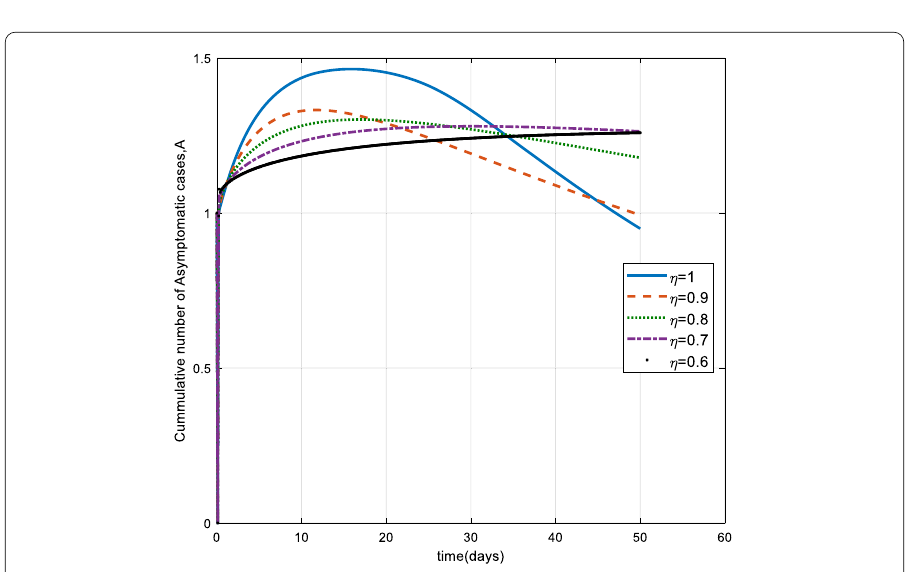
Figure 8 Number of asymptomatic cases (A) with control for different values of the fractional derivative order